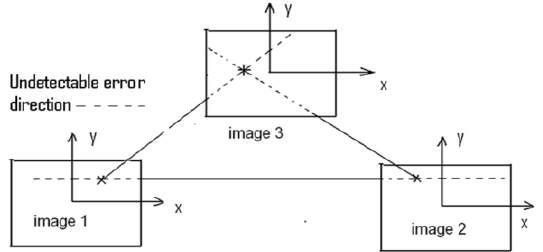
Figure 7. Multi-coplanarity condition based filter